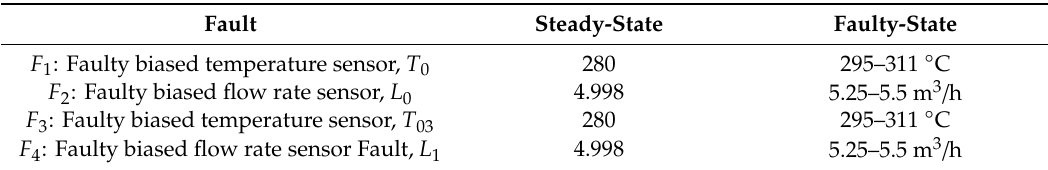
Table 2. Fault scenarios for